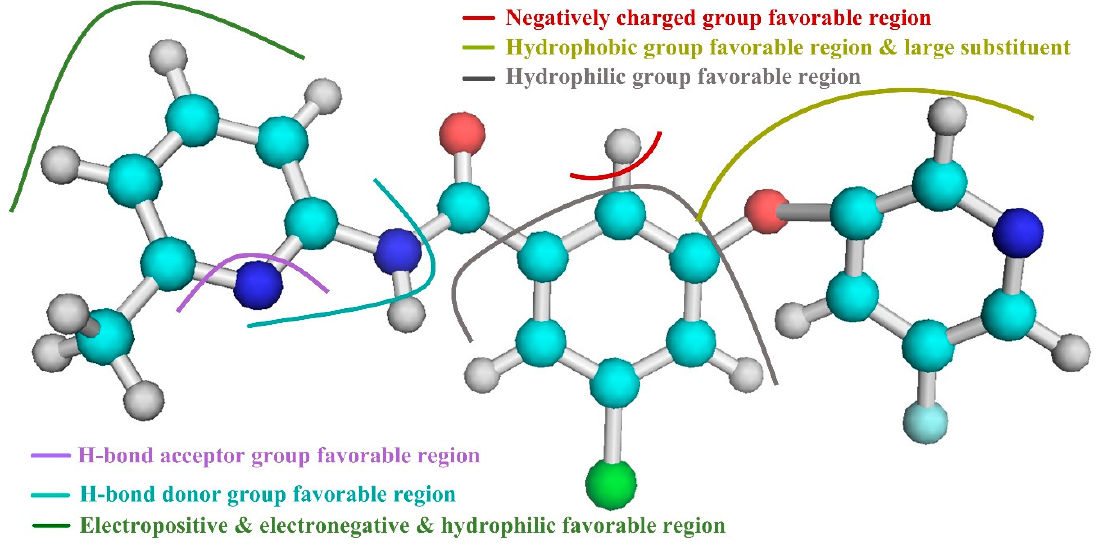
Figure 3. Key structural features of aryl benzamide-based mGluR5 negative allosteric modulators (NAMs) molecules that impact their inhibitory effects.